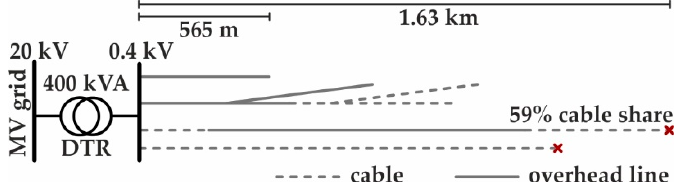
Figure 3. Simplified one-line diagram of the LV_link-grid model.